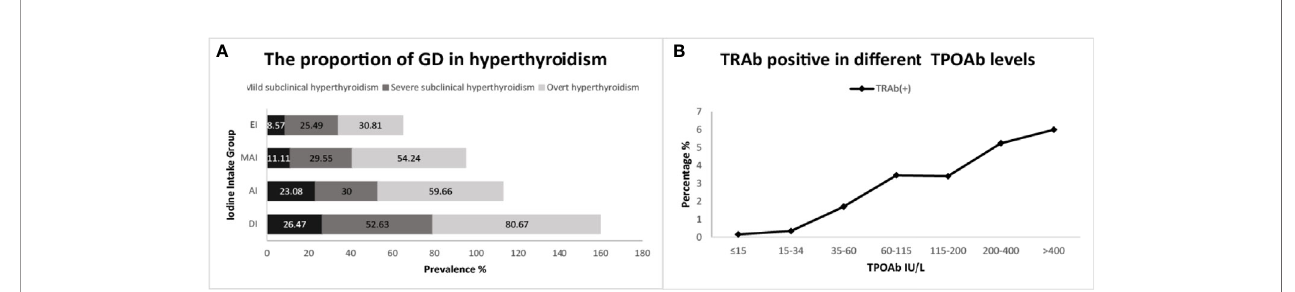
FIGURE 2 | (A) refers to the proportion of subjects with Graves ’ disease (GD) in hyperthyroidism; (B) refers to the proportion positive for TSH receptor antibodies (TRAb) across thyroid peroxidase antibody (TPOAb) groups.